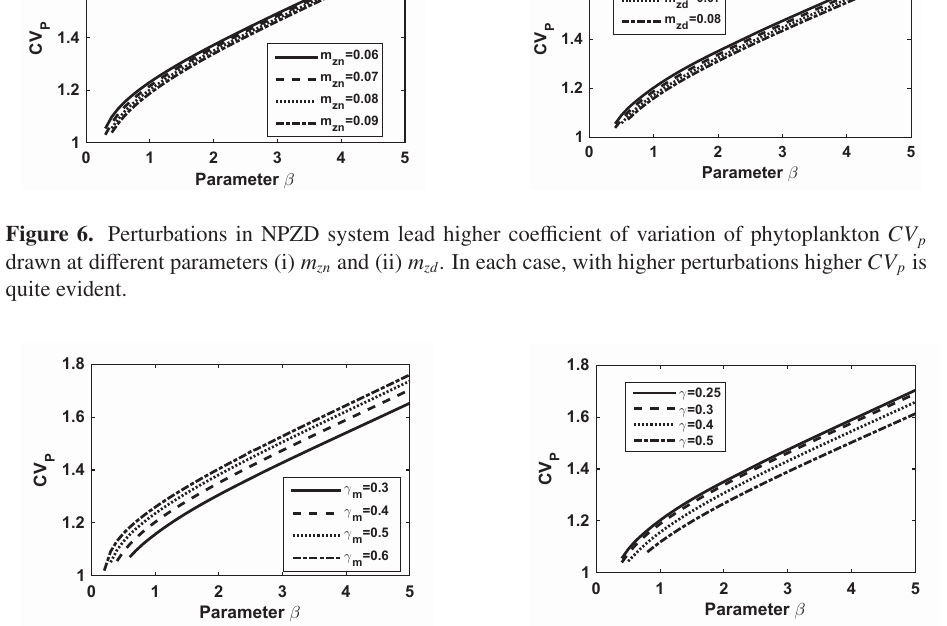
Figure 7. Perturbations in NPZD system lead higher coe ffi cient of variation of phytoplankton CV p drawn at di ff erent parameters (i) γ m and (ii) γ . In each case, with higher perturbations higher CV p is quite